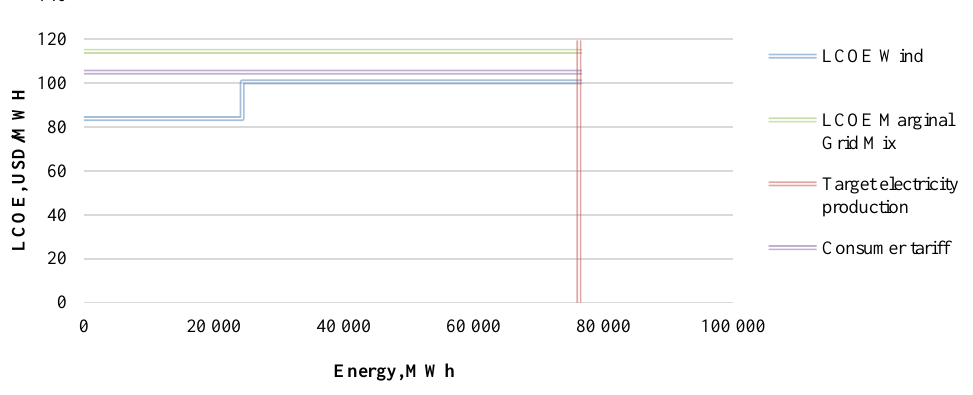
Fig. 6. LCOE comparison for wind